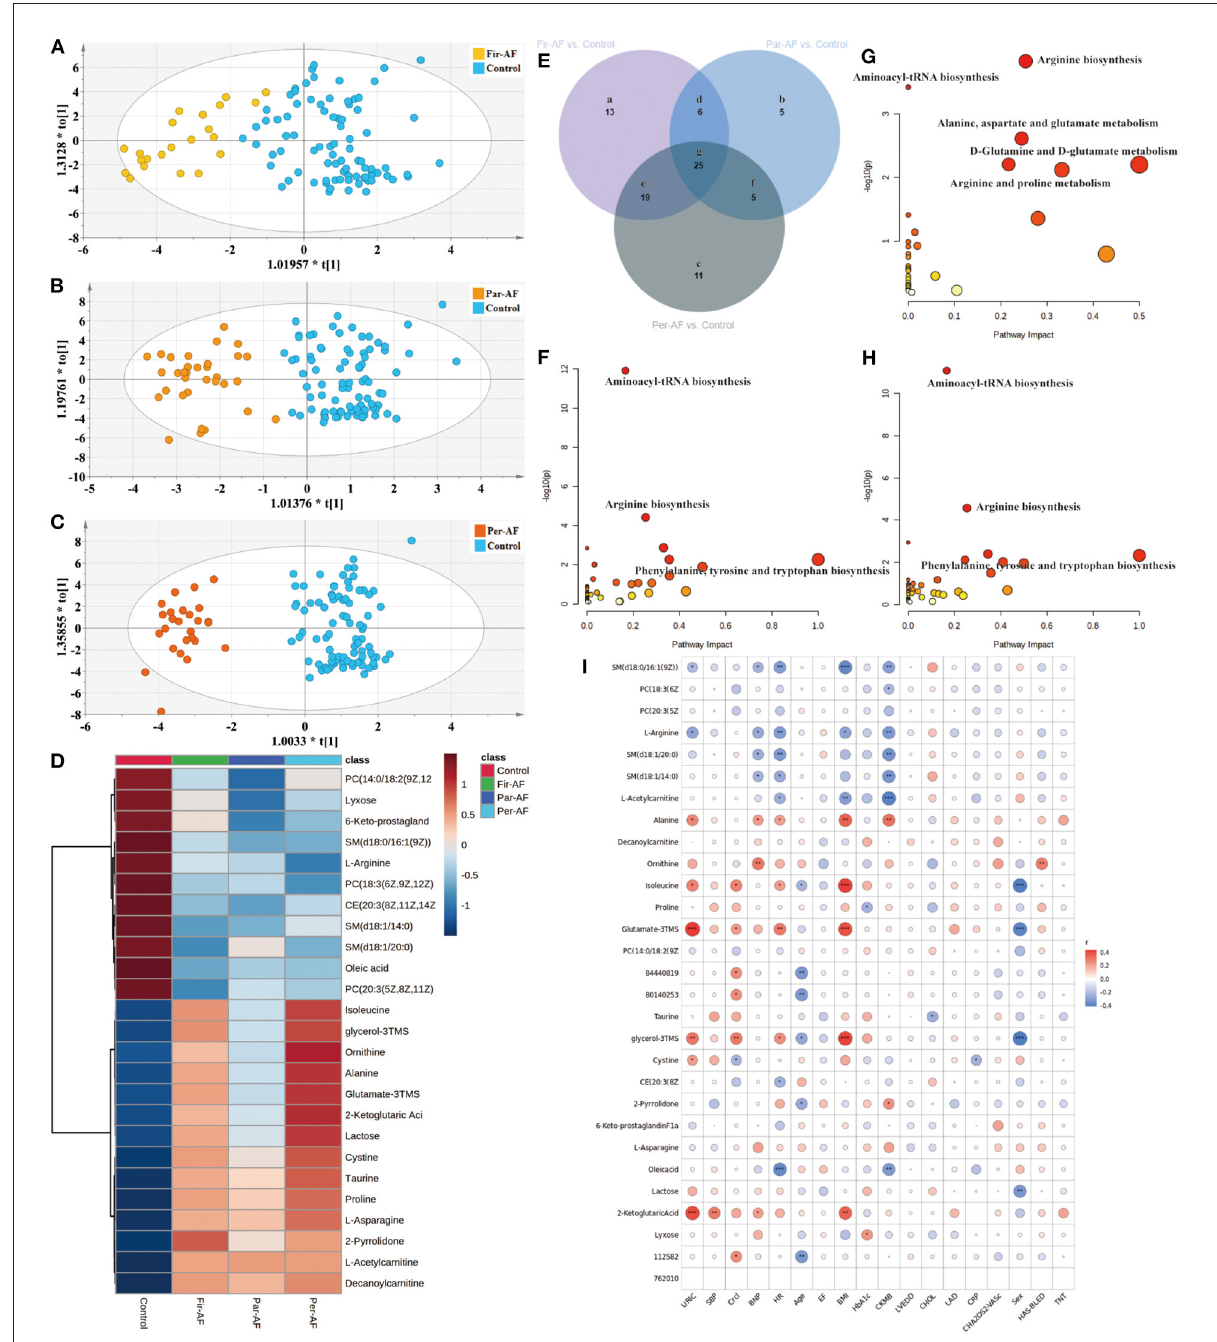
FIGURE6 Differential metabolites and pathways involved in the AF groups. (A–C) OPLS-DA modeling delineates different metabolic phenotypes of Fir-AF, Par-AF, and Per-AF cardiac cases from Control. R2X (cum) = 0.272, R2Y (cum) = 0.679, Q2X (cum) = 0.536; Permutation tests with the intercepts of R2 < 0.325, Q2 < -0.34. R2X (cum) = 0.315, R2Y (cum) = 0.812, Q2X (cum) = 0.633; Permutation tests with the intercepts of R2 < 0.458, Q2 < -0.473. R2X (cum) = 0.351, R2Y (cum) = 0.893, Q2X (cum) = 0.706; Permutation tests with the intercepts of R2 < 0.323, Q2 < -0.312. (D) Heatmap of the 25 differential metabolites in Control and all kinds of AFs. The colors changing from blue to red indicate high metabolites. (E) Venn diagram shows discriminant metabolites can be classified into 7 regions. (F) Pathway analysis of differential metabolites in Venn a, d, e, and g regions. (G) Pathway analysis of differential metabolites in Venn b, d, f and g. (H) Pathway analysis of differential metabolites in Venn c, e, f, and g regions. (I) The correlation coefficients between 25 potential biomarker contents and clinical characteristics. Blue represents negative correlation, and red represents positive correlation. Circle size represents the r -value of the metabolites and clinical characteristics. The symbol from * to ** and *** indicate the P -values between metabolites and clinical characteristics. * p < 0.05, ** p < 0.01, and *** p <